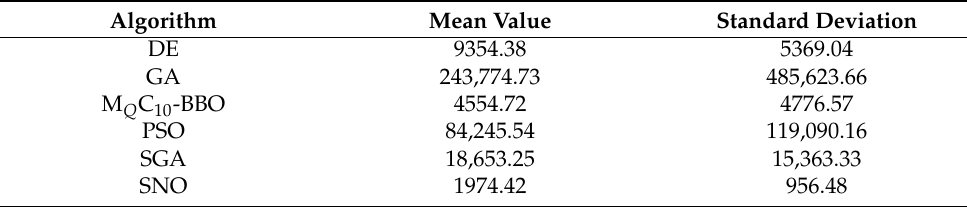
Table 1. Comparison between the mean values and the standard